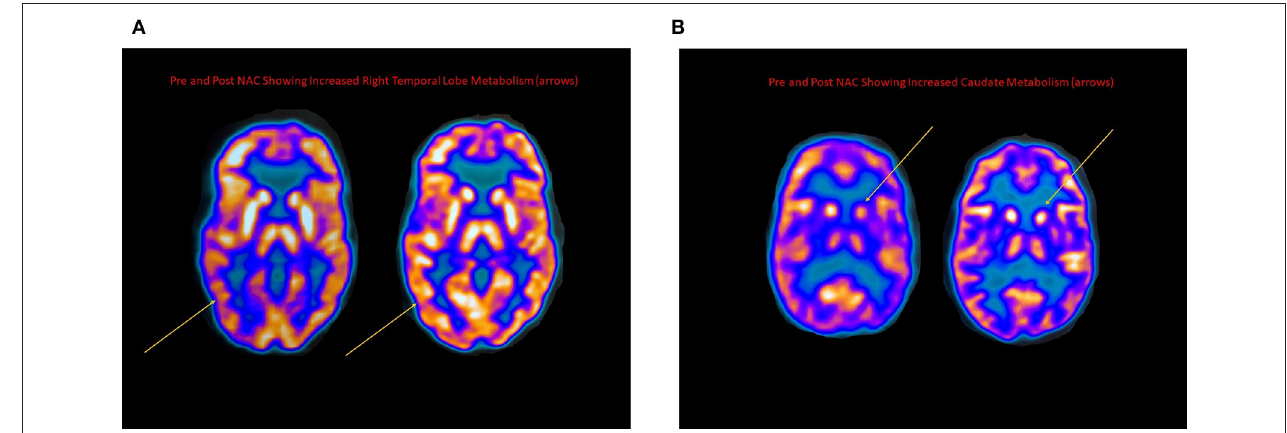
FIGURE 2 | (A) FDG PET scans taken pre and post-NAC for an MS patient demonstrating marked improvement in the right temporal lobe cerebral glucose metabolism (arrows). (B) FDG PET scans taken pre and post-NAC for an MS patient demonstrating marked increase in caudate glucose metabolism (arrows).